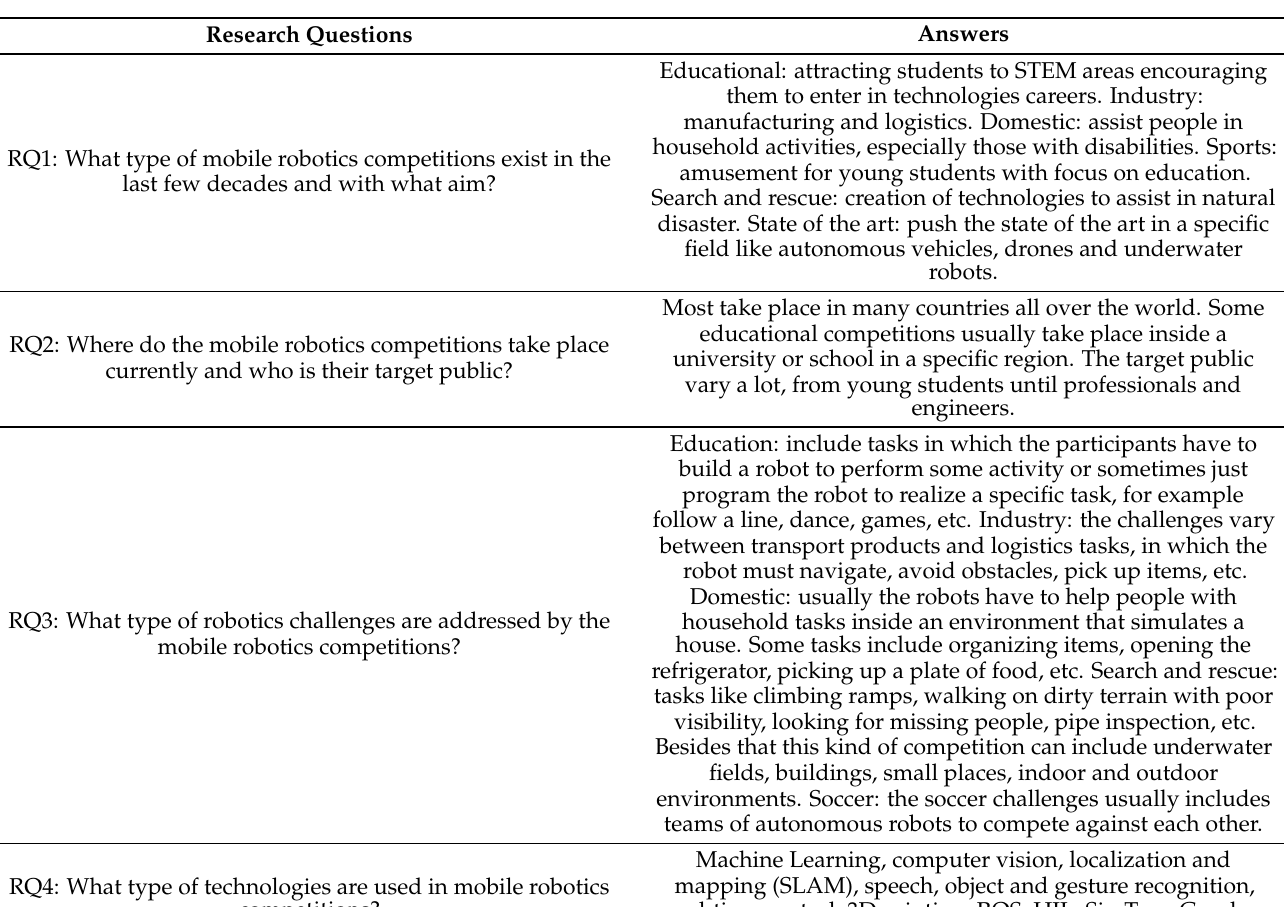
Table 6. Summary of the research questions